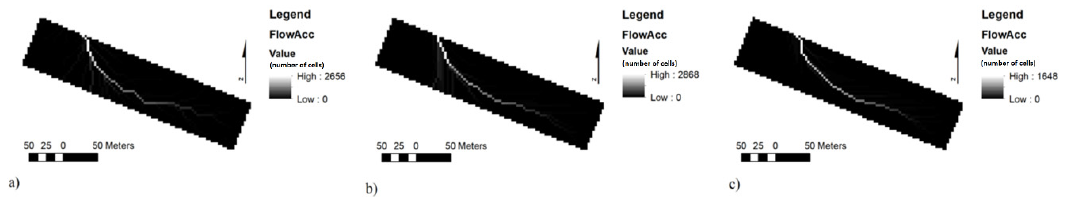
Figure 5. Map of flow accumulation: ( a ) aerial photographs, ( b ) aerial laser scans, ( c ) terrestrial laser scans.